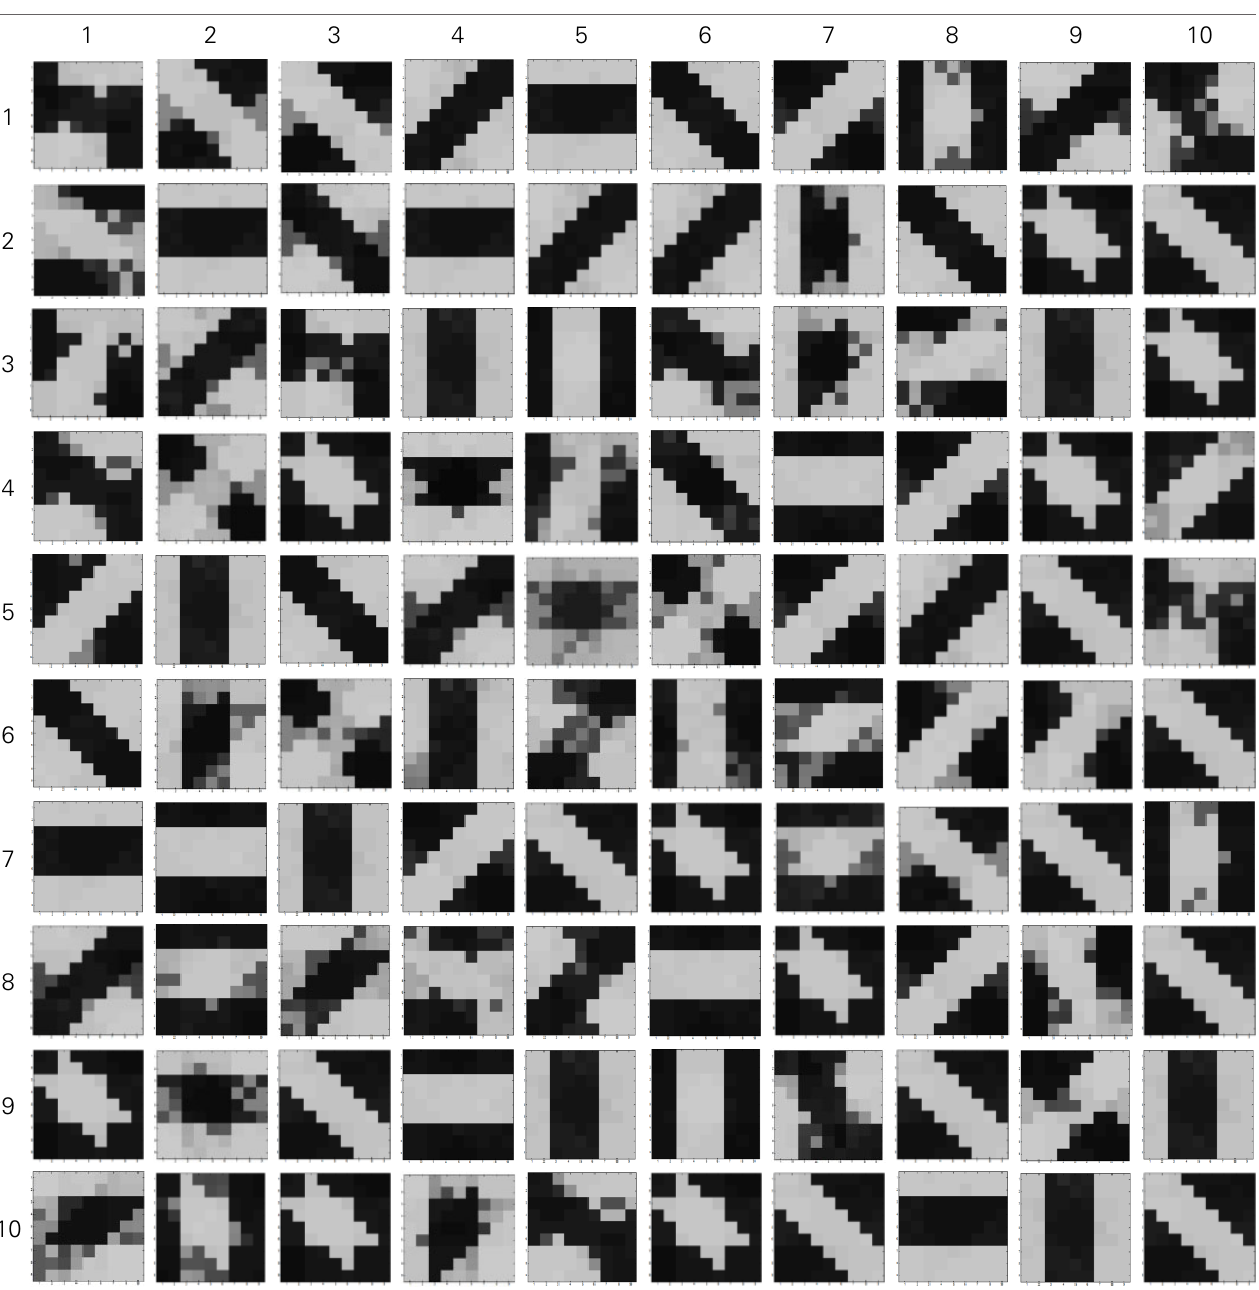
Table 1A | Results of 100 simulations of the orientation selective cell performed with different random initial biases and different random-inside-epoch